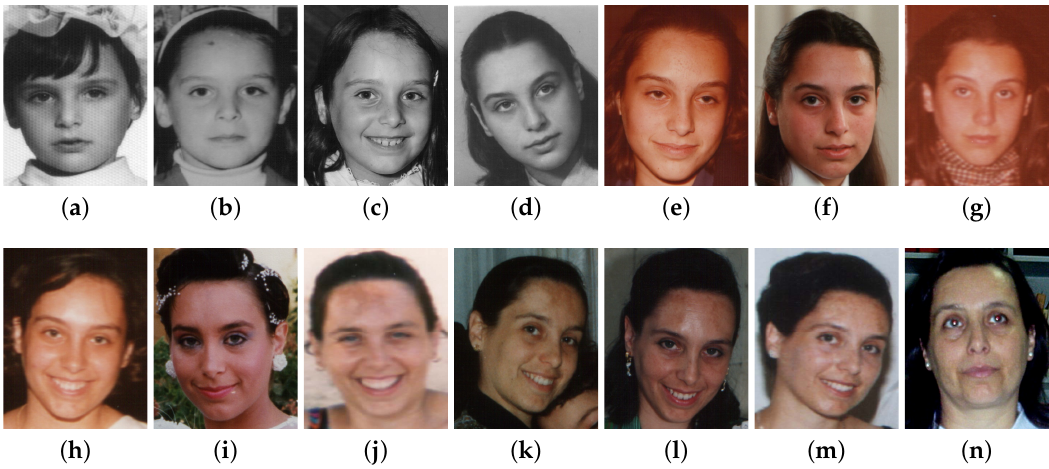
Figure 1. Facial image examples of one subject in sequential order of different age values in the FG-NET database [23]. ( a ) 4; ( b ) 5; ( c ) 7; ( d ) 15; ( e ) 16; ( f ) 18; ( g ) 20; ( h ) 21; ( i ) 23; ( j ) 26; ( k ) 29; ( l ) 31; ( m ) 36; ( n )